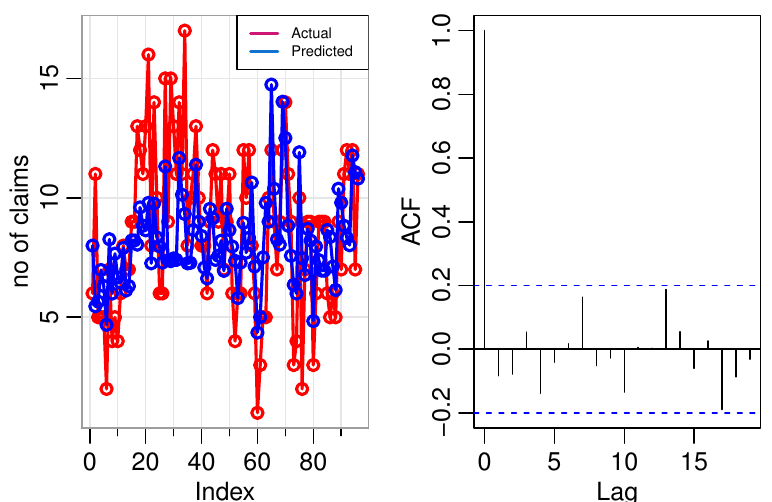
Figure 7. The predicted values of the number of claims dataset ( left ) and the ACF plot of the Pearson residuals ( right